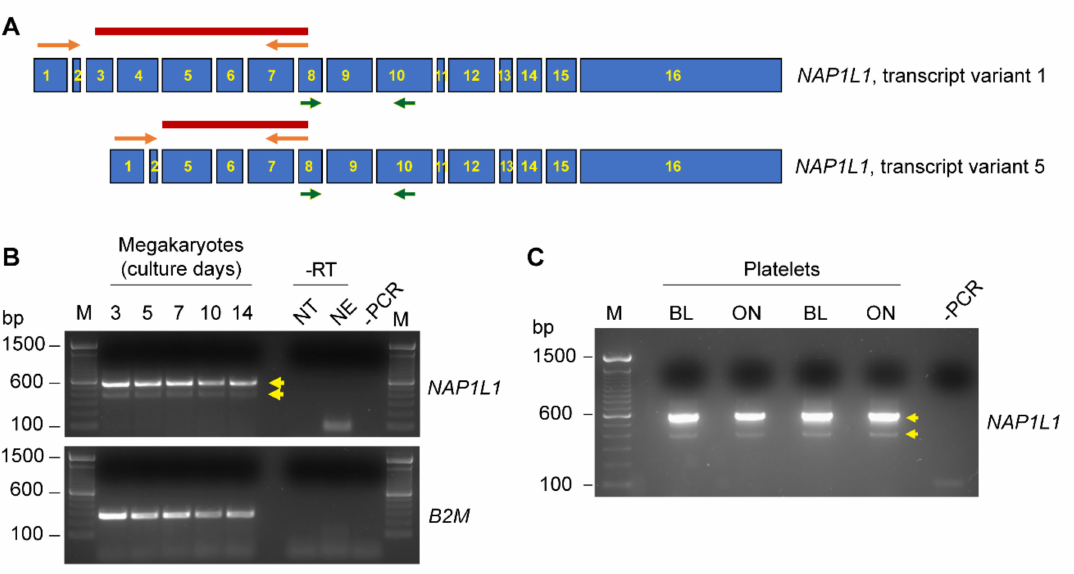
Figure 2. MKs and human PLTs express alternative NAP1L1 transcript variants. ( A ) Schematic representation of the organization of exons in NAP1L1 transcript variant 1 ( top ), and transcript variant 5 ( bottom ) missing exons 3 and 4. Primer binding sites for transcript variant 1 detection (green, as used in Figure 1) and transcript variant 5 (orange), and the expected PCR products (dark red) are indicated. ( B ) MKs at culture days 3, 5, 7, 10, and 14 were examined for NAP1L1 expression by PCR. NT represents the reverse transcription (RT) reaction using no template, NE represents the RT reaction using no enzyme. Both controls were performed to control for contaminating nuclear DNA. Bottom , B2M as a loading control. This figure is representative of 5 independent experiments. ( C ) RNA from freshly isolated PLTs at baseline (BL) and after culture overnight (ON) was isolated and NAP1L1 mRNA expression was evaluated by PCR. This figure is representative of 10 independent experiments. The -PCR lane shows the negative control for the PCR reaction, lanes labeled with M indicate the marker lane. Relevant PCR products are indicated by yellow